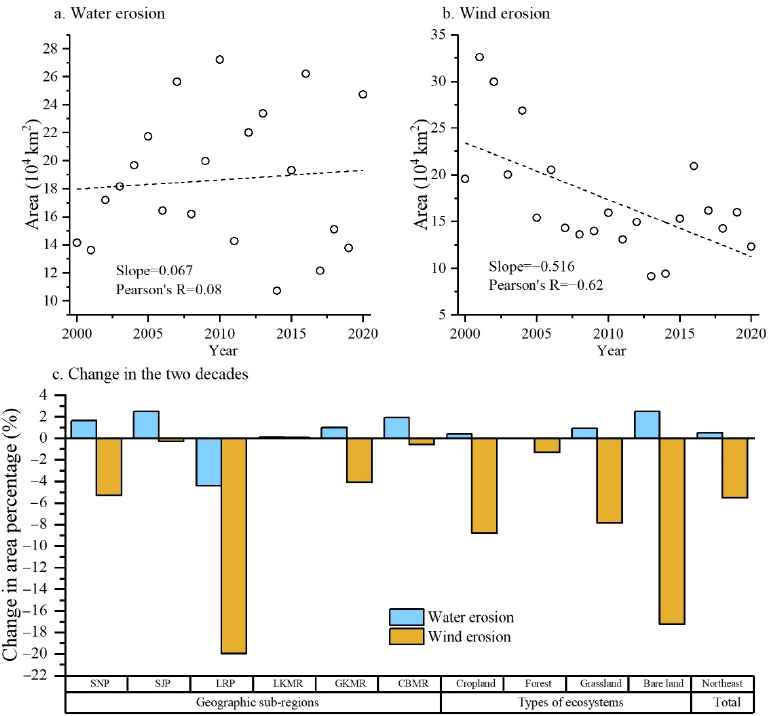
Figure 4. Soil erosion at light or higher degrees: ( a ) year-to-year change in water erosion area, ( b ) year-to-year change in wind erosion area, ( c ) change in percentage of area in the second decade